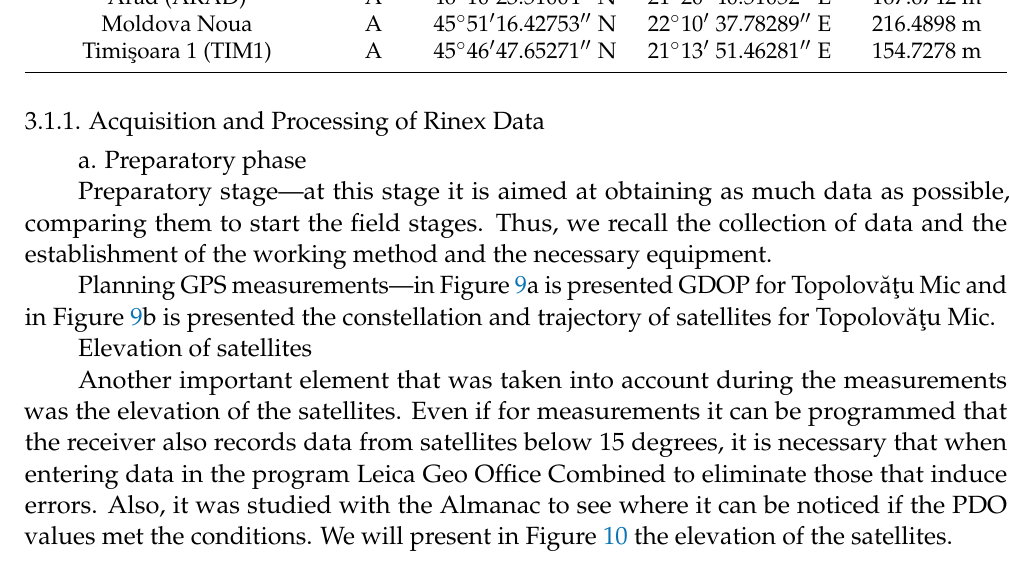
Table 4. GNSS permanent stations used in post-processing. Ellipsoidal coordinates—ETRS89. Name of Standing